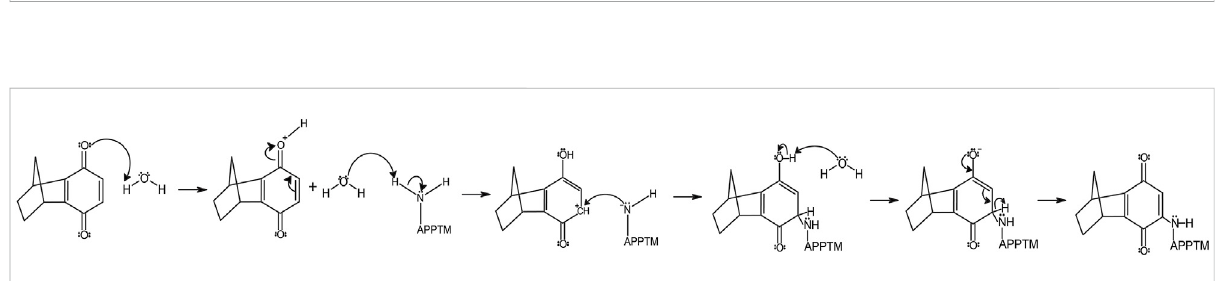
FIGURE 7 The proposed mechanism of covalent modi fi cation of APPTM by 6H8 at Lys residues follows a Micheal addition mechanistic